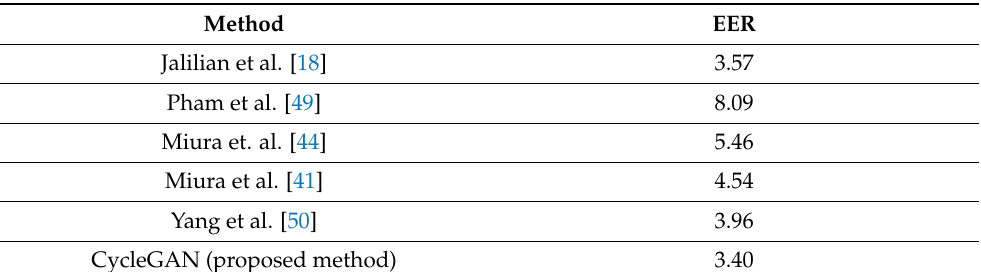
Table 11. Comparisons of EER of the state-of-the-art methods and proposed method in case of training with HKPolyU-DB and testing with SDUMLA-HMT-DB (unit: